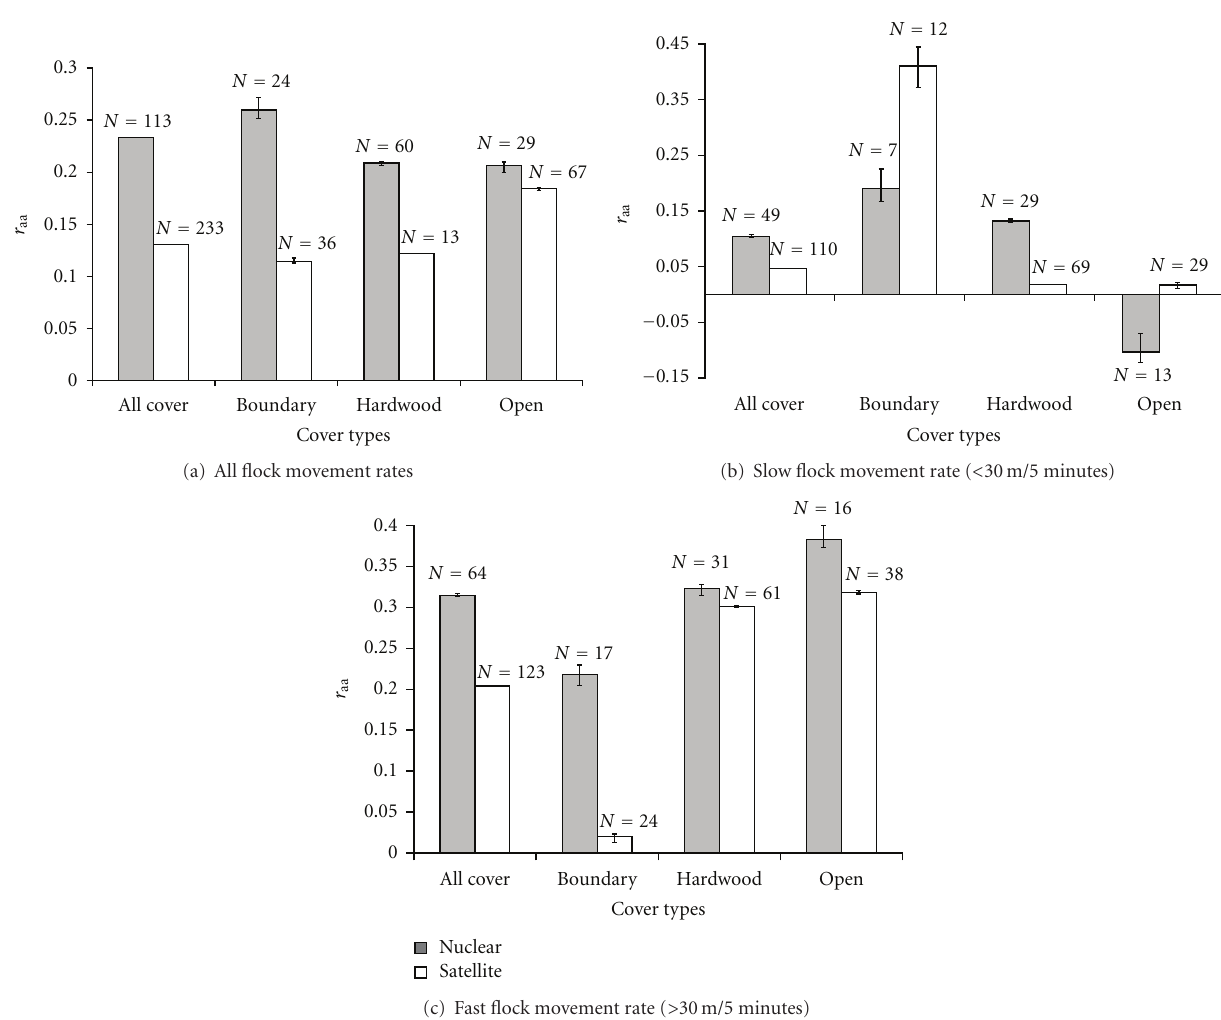
Figure 3: Angular-angular correlation coe ffi cients ( r aa ) for correlations between the movement direction of nuclear (TUTI; gray bars) or satellite (white) flock participants and flock movement direction in all cover types combined (All Cover), boundary (boundary between hardwood and open cover), hardwood, and open cover types. The sample size for each coe ffi cient is above each bar. (a) Correlation coe ffi cients in di ff erent cover types for all flock movement rates; (b) Correlation coe ffi cients in di ff erent cover types for slow flock movement rates ( < 30m/5 minutes); (c) Correlation coe ffi cients in di ff erent cover types for fast flock movement rates ( > 30m/5 minutes). Error bars represent 95% confidence intervals for each r aa . Missing error bars represent 95% confidence intervals that were too small to be visible (CI <